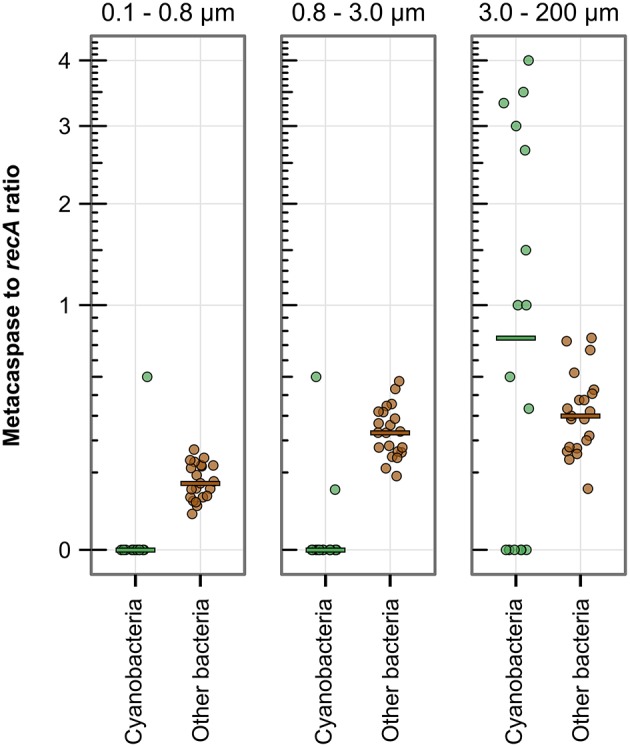
Metacaspase gene abundance among bacteria compared by size fraction in the metagenomes along the 2009 Baltic Sea transect (Phase I; 21 stations). The abundance is the ratio of bacterial metacaspase to recA sequences, displayed on a square root scale. The horizontal bars indicate the median values. When combining Cyanobacteria and Other bacteria, the two larger size fractions are significantly different from the smaller, i.e., the larger size fraction bacteria have a higher metacaspase abundance. Significant differences are given in detail in Table S3.